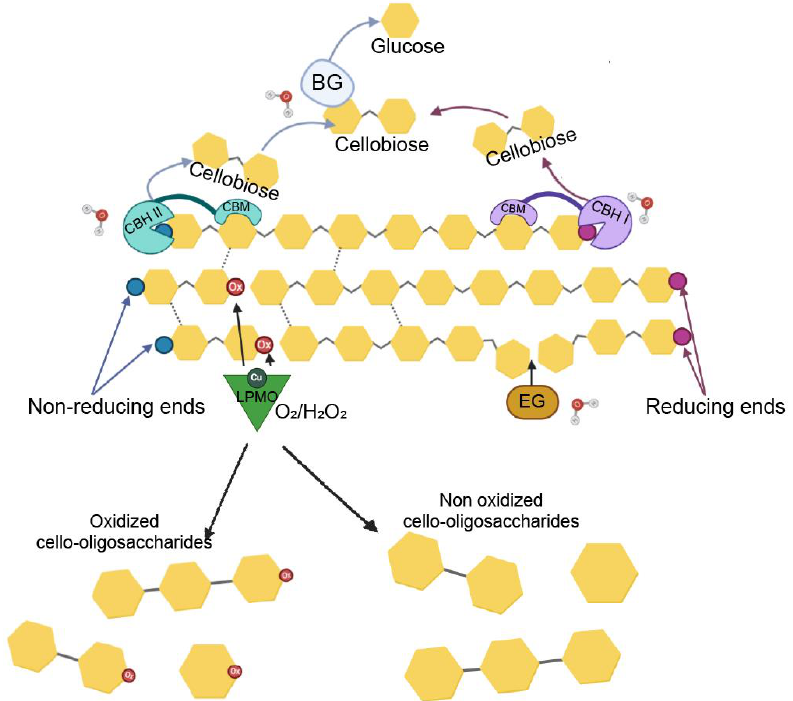
Figure 1. Schematic representation of enzymes acting in the deconstruction of cellulose. LPMOs (C1- oxidizing: EC 1.14.99.54; C4-oxidizing: EC1.14.99.56) use either O 2 or H 2 O 2 to hydrolyze cellulose chains in the crystalline regions, making the cellulose more accessible for the action of hydrolytic enzymes. Endoglucanases (EG; EC 3.2.1.4) hydrolyze the glycosidic bond in the amorphous regions of the cellulose chains, generating new reducing and non-reducing ends. Cellobiohydrolases (EC 3.2.1.91) processively release cellobiose units from the reducing (CBH I) and non-reducing (CBH II) ends of the cellulose chains. Cellobiose is then converted into glucose units by β -glucosidases (BG; EC 3.2.1.21). Ox, oxidated glucose moiety; CBM, carbohydrate binding module.